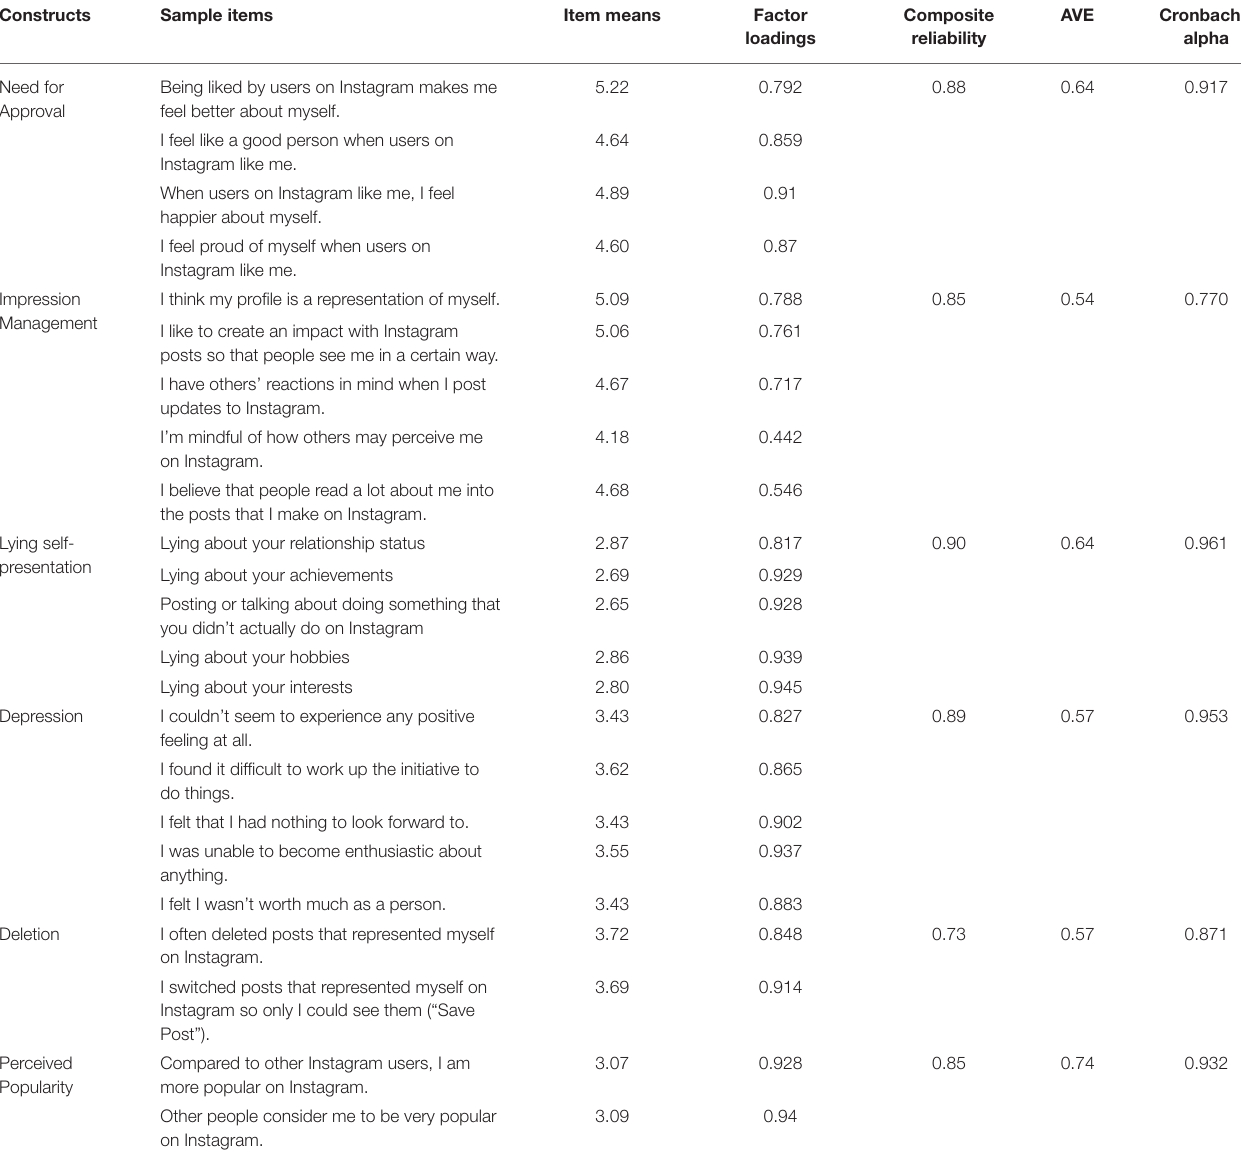
TABLE 1 | Sample items, means, and Cronbach’s alpha scores for each